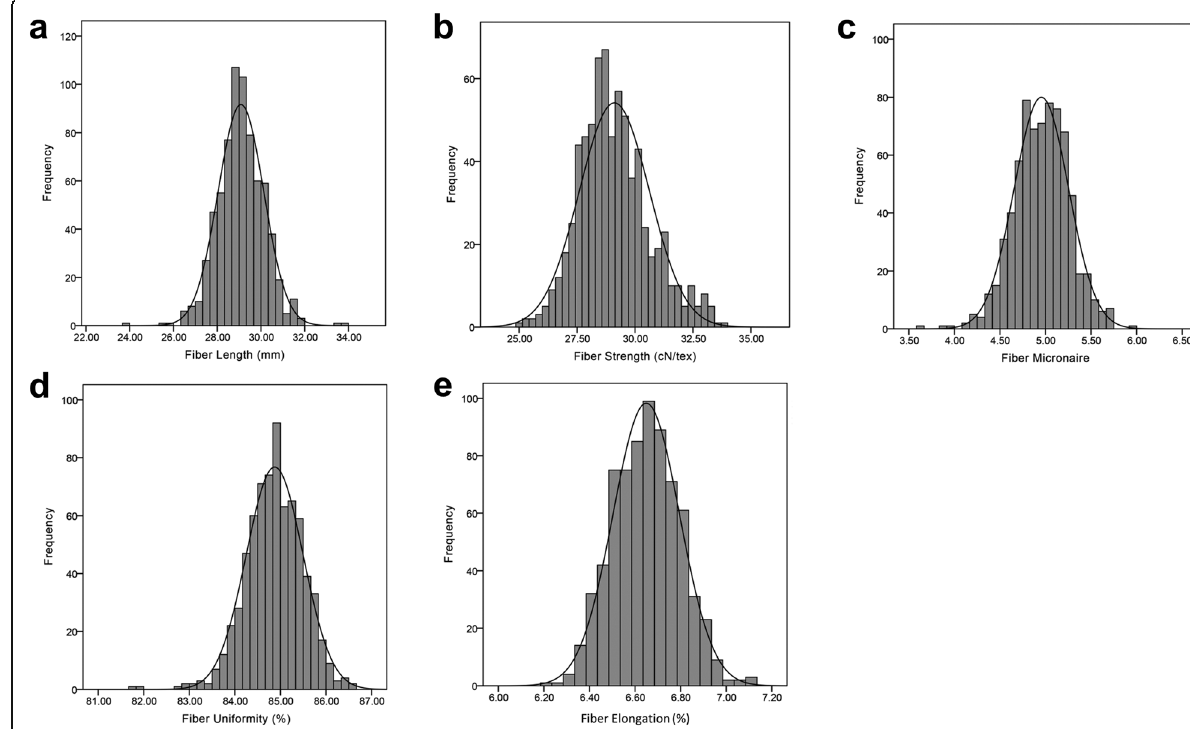
Fig. 1 Frequency distribution of 719 Gossypium hirsutum L. accessions for five fibre quality traits. a Fibre length; b Fibre strength; c Fibre micronaire; d Fibre uniformity; e Fibre